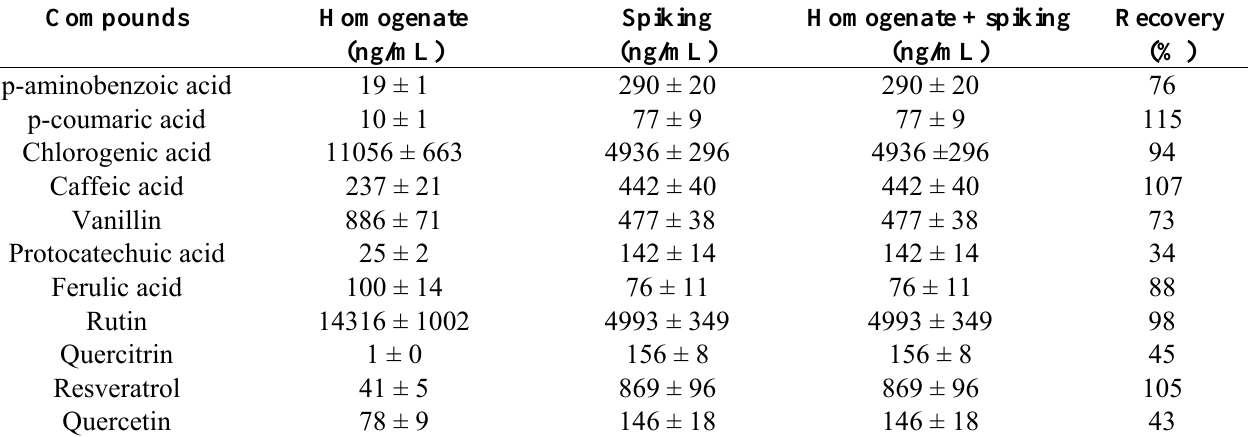
Table 9. Shaking 22 °C.